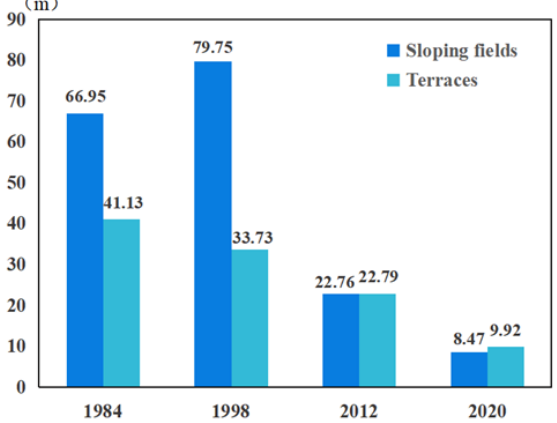
Figure 3. Average relative altitude of croplands from 1984 to 2020.